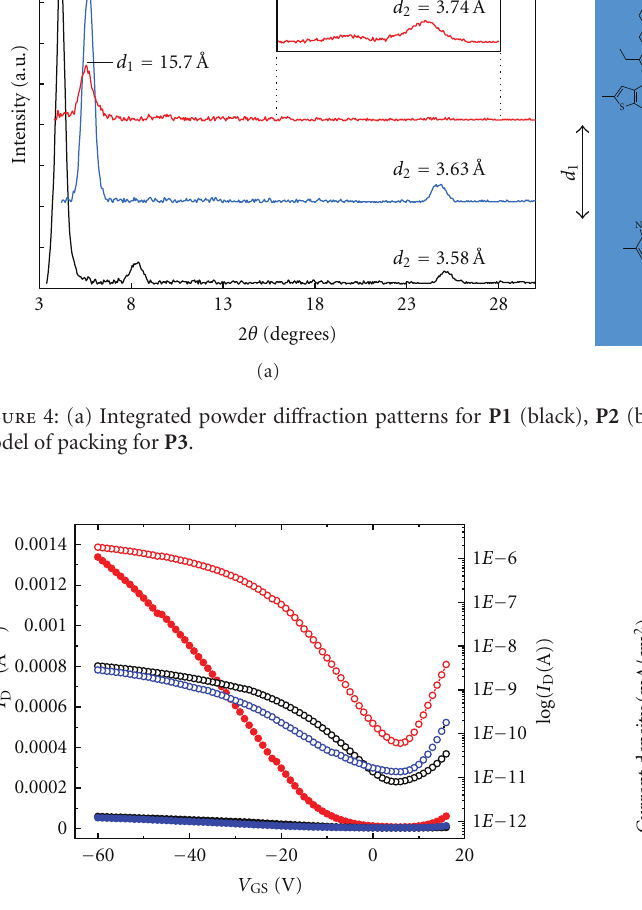
Figure 5: Electrical characteristics of P1 (black), P2 (blue), and P3 (red). Each device has dimensions L = 5 μ m and W = 1000 μ m. A plot of the log( I D ) versus V GS in open symbols (right axis) and the I 1 / 2 D versus V GS in solid symbols (left axis) in the saturation regime ( V DS = − 60V) are shown.